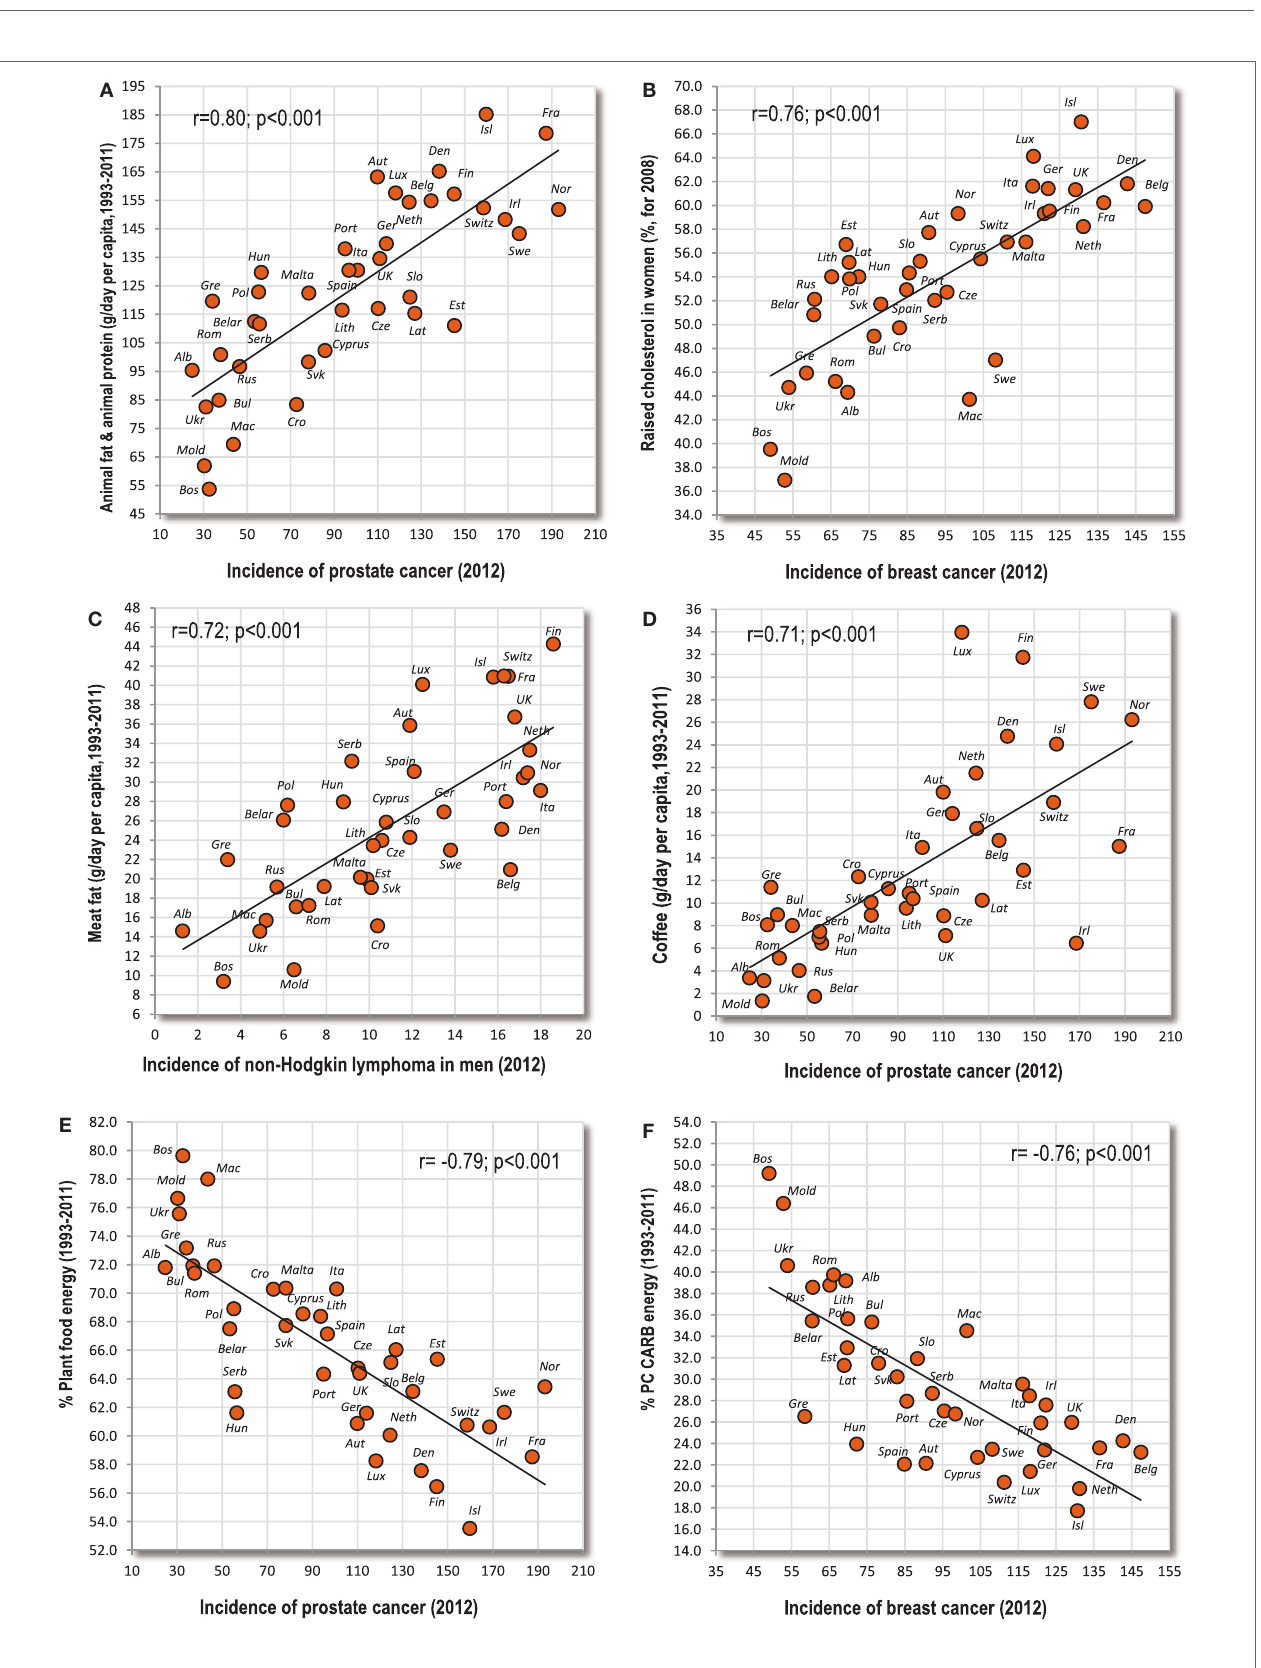
FigUre 1 | (a–F) Relationship between major independent variables and cancers of the prostate, breast, and white blood cells (non-Hodgkin